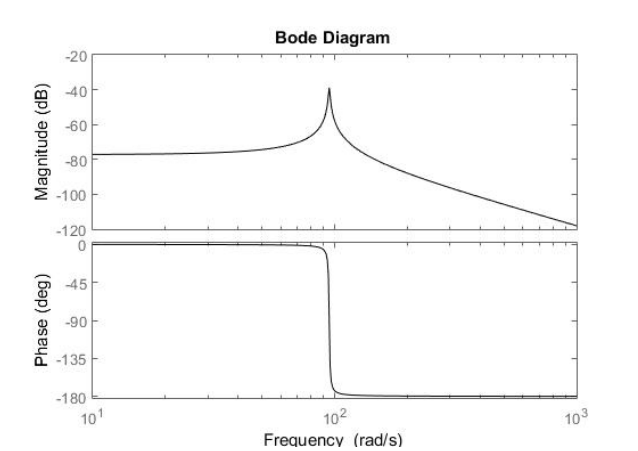
Fig. 4 Bode diagram of the uncompensated structure.